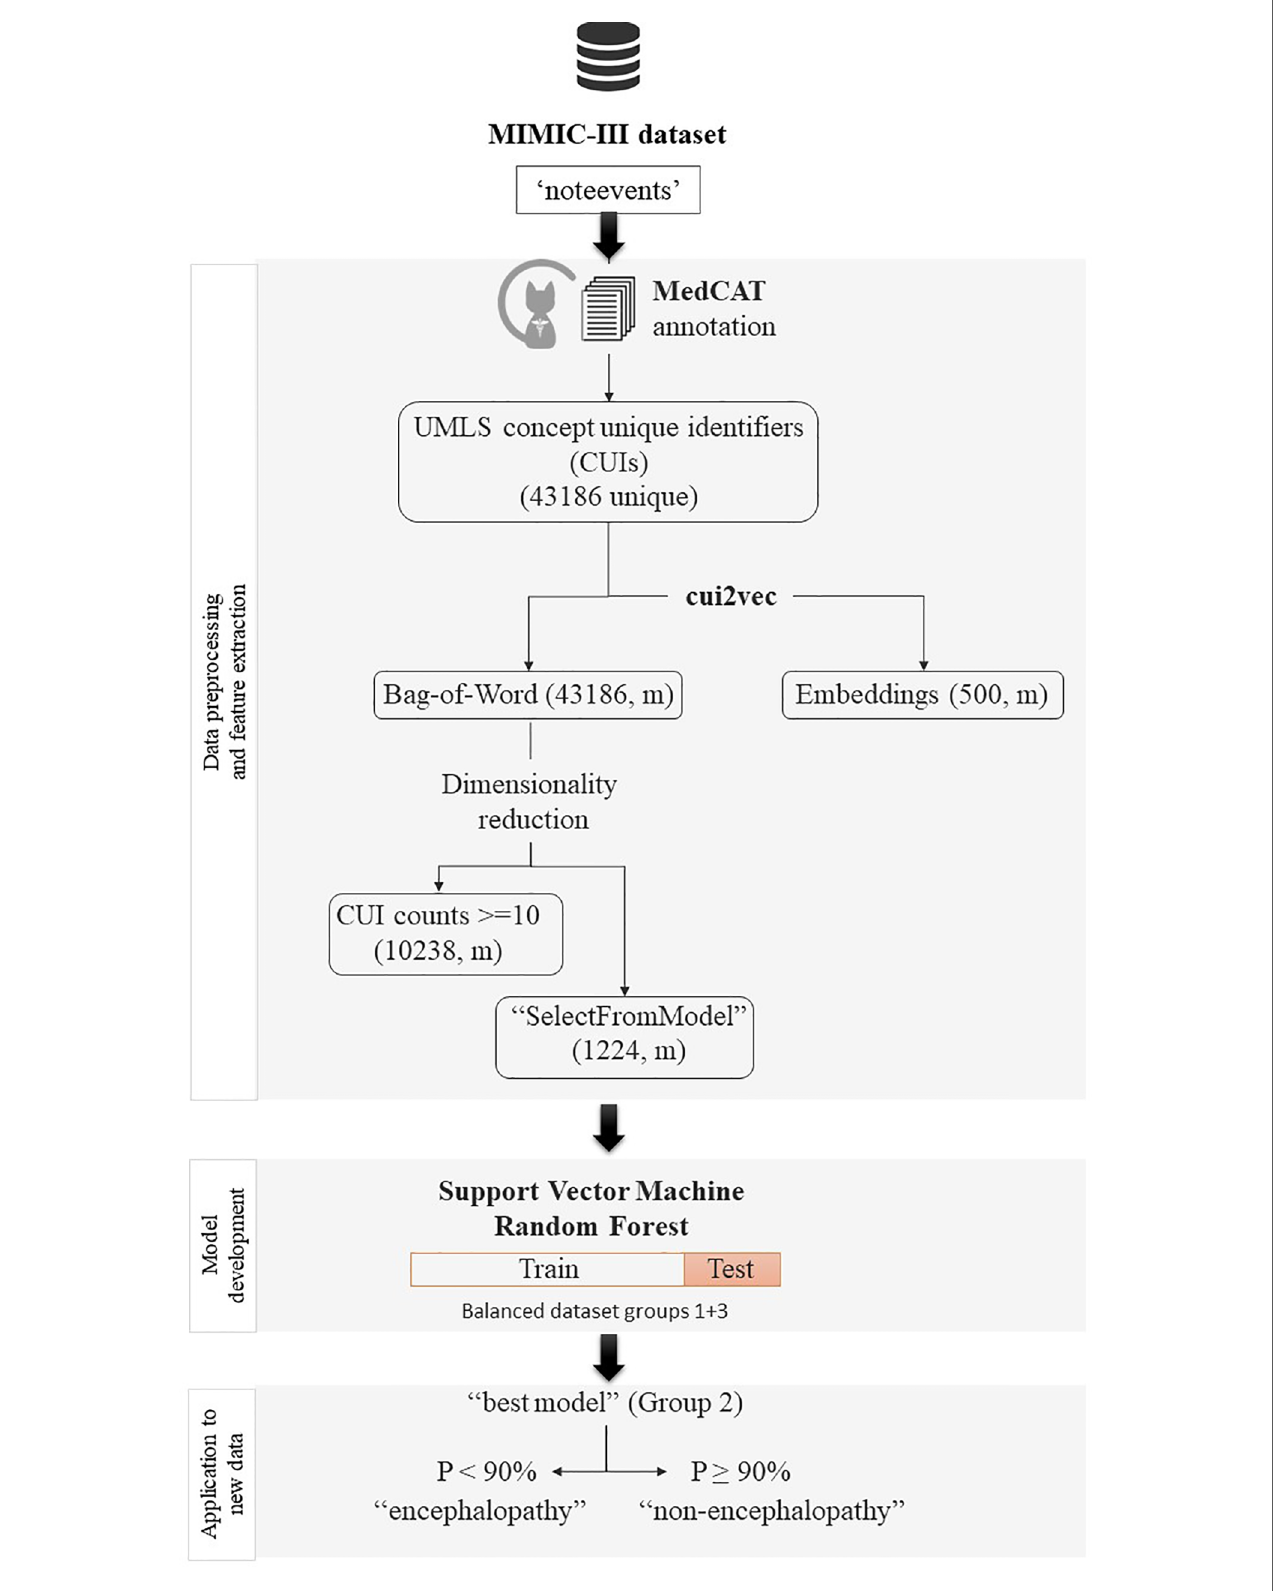
FIGURE 2 Flowchart of pre-processing, cohort de fi nition and classi fi cation. Graph that sumarises the fl owchart of processing of the data, from the inclusion criteria to the fi nal binary classi fi cation task to identify encephalopathy among patients without a formal diagnosis.